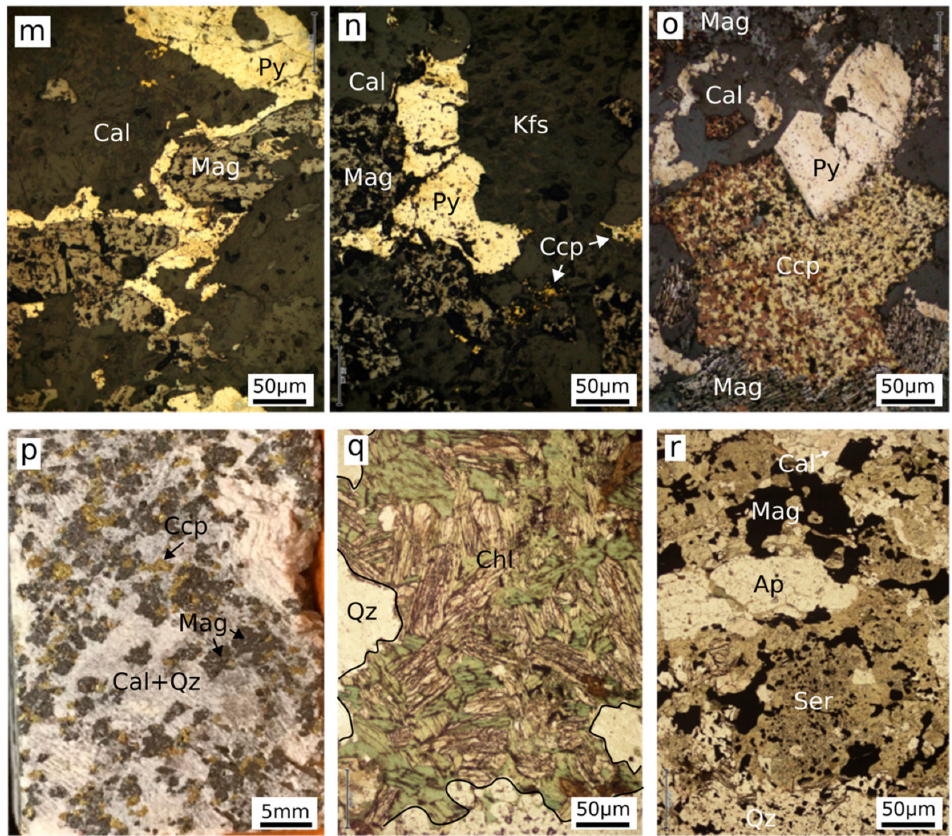
Figure 5. Mineralogy of the Inter-lens: ( a ) Porphyritic metavolcanic host rock possessing albite (Ab) phenocrysts; ( b ) XPL photomicrograph of fine-grained calcite (Cal) and Quartz (Qz) with minor apatite (Ap) displaying a quartzite texture; ( c ) PPL photomicrograph of fine-grained biotite-rich schist interlayered with a calcite and quartz-rich lithology; ( d ) XPL photomicrograph of an albitized metaandesite breccia clast; ( e ) Coarse-grained apatite-calcite-quartz vein surrounded by paragenetically later biotite (Bt) and magnetite (Mag) with minor garnet (Grt), pyrite (Py), and chalcopyrite (Ccp); ( f ) Coarse-grained apatite-rich vein partially overprinted by subsequent biotite-magnetite alteration; ( g ) Angular to sub-angular apatite disseminated throughout a biotite-magnetite-rich matrix; ( h ) Coarse-grained banded garnet associated with biotite-magnetite alteration; ( i ) Intensely foliated biotite-magnetite alteration. Inset of the XPL photomicrograph shows non-foliated biotite on a microscopic scale. ( j ) XPL photomicrograph of coarse-grain K-feldspar (Kfs) forming in and around quartz, apatite, and magnetite; ( k ) PPL photomicrograph showing texturally destructive K-feldspar and hornblende (Hbl) altering a previous assemblage of apatite, quartz, and magnetite; ( l ) XPL photomicrograph of texturally destructive K-feldspar and hornblende altering a previous assemblage of calcite, apatite, and magnetite with a late overprinting pyrite grain; ( m ) RL photomicrograph of pyrite growing in and around paragenetically younger calcite and magnetite grains; ( n ) RL photomicrograph of pyrite growing in and around earlier K-feldspar, magnetite, and calcite. Minor chalcopyrite (Ccp) replaces magnetite and also grows around K-feldspar; ( o ) RL photomicrograph of coarse-grained chalcopyrite replacing magnetite and pyrite, while growing in and around calcite; ( p ) Stage 2 magnetite, pyrite and chalcopyrite-rich breccia dominated by a groundmass of calcite and quartz; ( q ) PPL photomicrograph of intense chlorite (Chl) alteration of biotite; ( r ) PPL photomicrograph showing sericite (Ser) alteration of apatite, quartz, calcite, and magnetite. (XPL = cross-polarized light; PPL = plane-polarized light; RL = reflected light). Mineral abbreviations follow Whitney and Evans